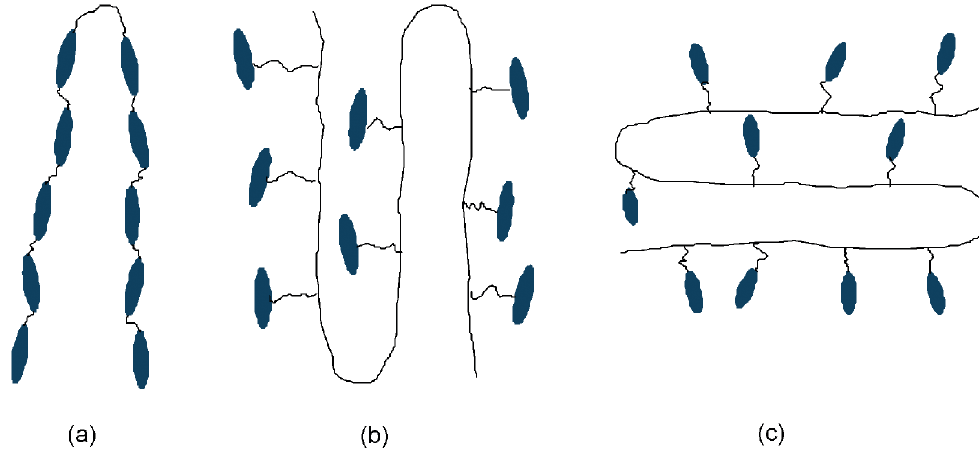
Figure 1. Schematic picture of MCLCPs (a), side-on SCLCPs (b), and end-on SCLCPs (c) 3 .